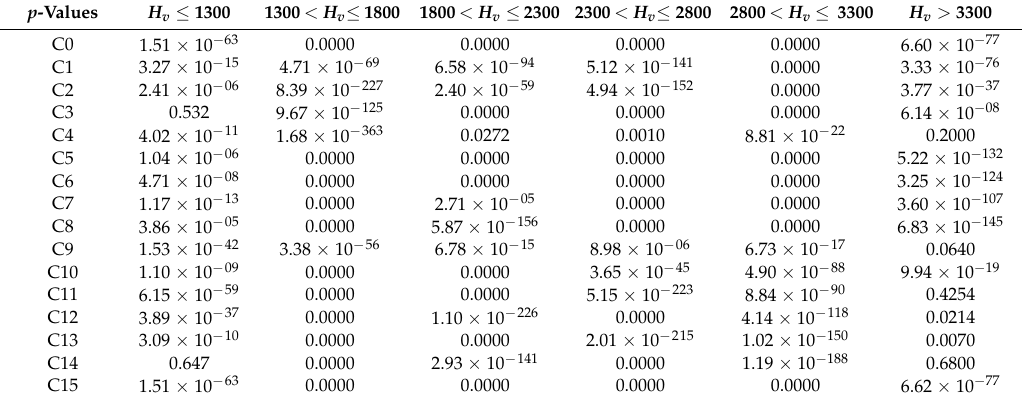
Table 2. p -Values of retrieved coefficients for different water vapor scale heights H v (m). p